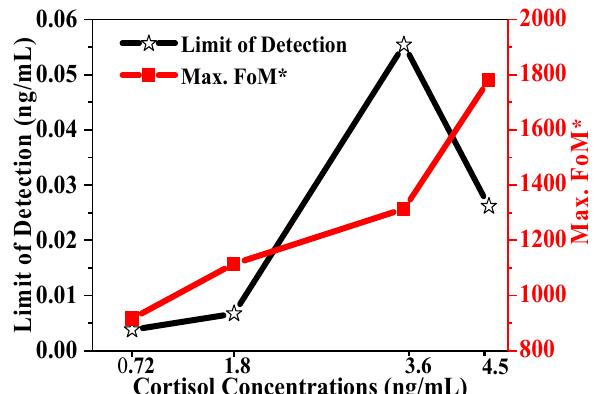
Figure 6. The angular figure of merit (FOM*) plotted against the incident angle for different cortisol concentrations (0.36 to 4.5 ng/mL).